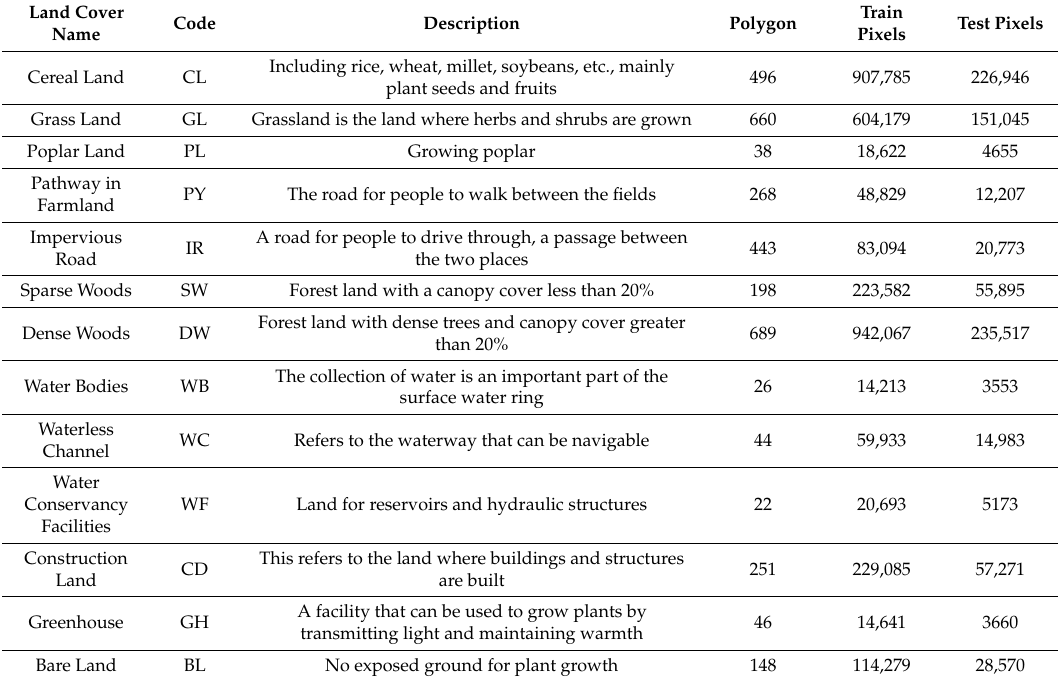
Table 1. Land cover description and the number of available polygons and pixels for training and testing for each